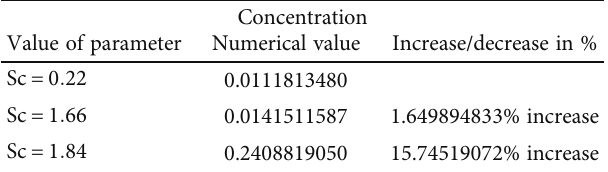
Table 13: Variability of the curve when Y = 1 in Figure